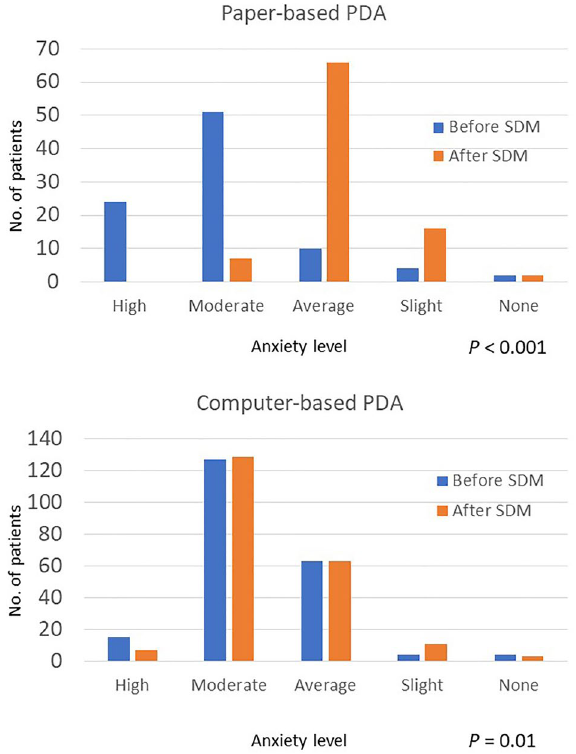
Figure 3. Comparison of anxiety level before and after SDM based on paper-based or